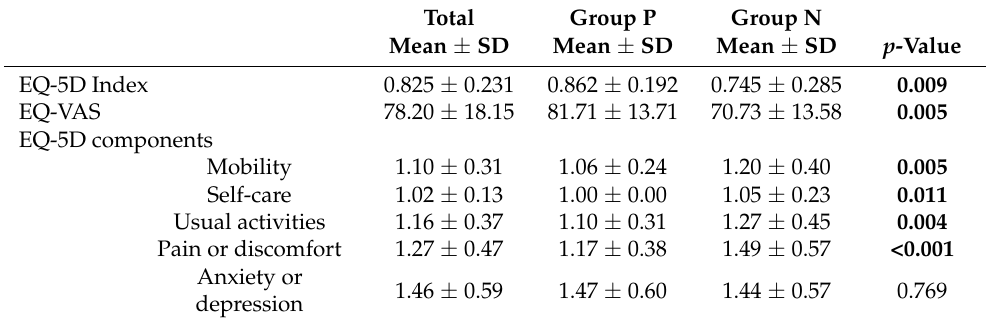
Table 3. Mean scores of validated questionnaires assessing health-related factors and perceived quality of life during the first wave of the COVID-19 pandemic (n = 172).